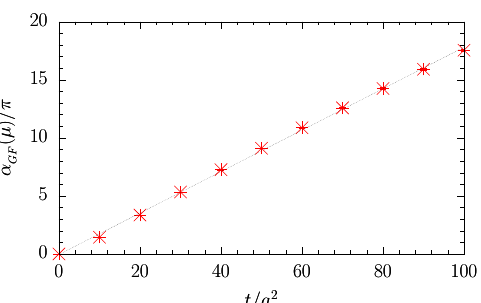
Figure 4. The gradient flow coupling α GF p µ q{ π on the 32 4 lattice as a function of t { a 2 “ 1 { 8 a 2 µ 2 , together with a linear